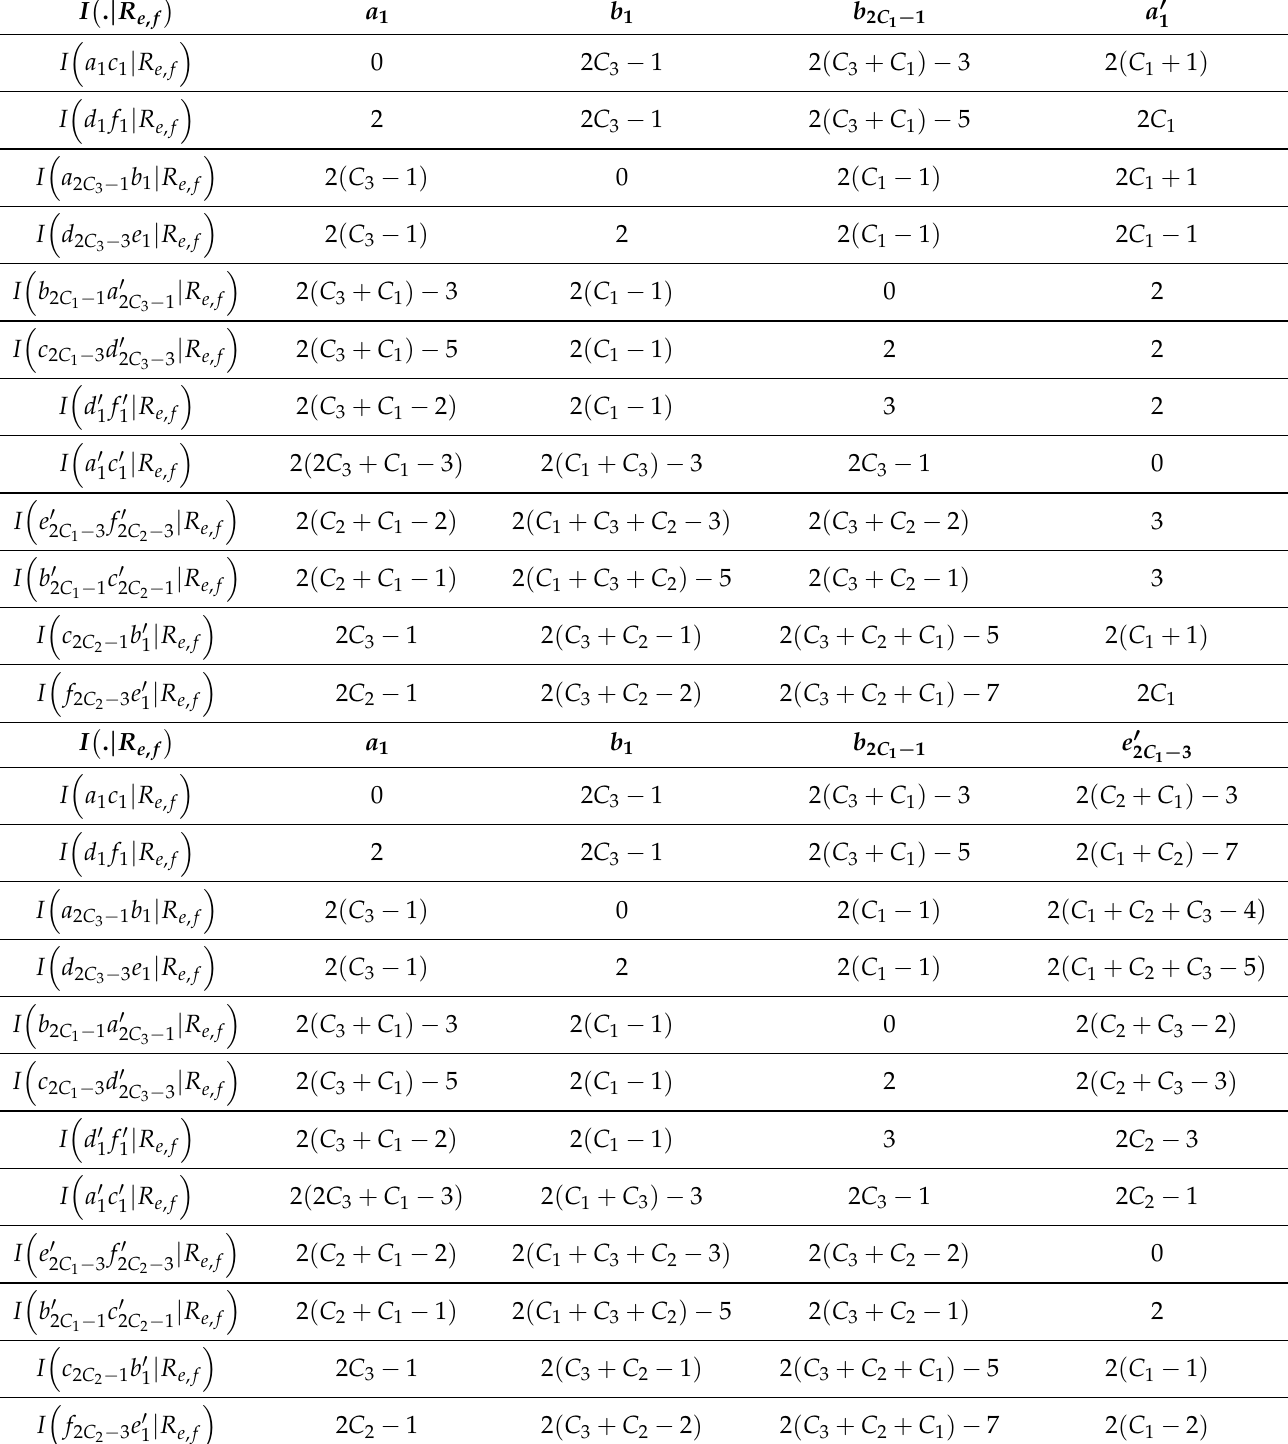
Table 2. Representation of edges with respect to resolving set R e , f